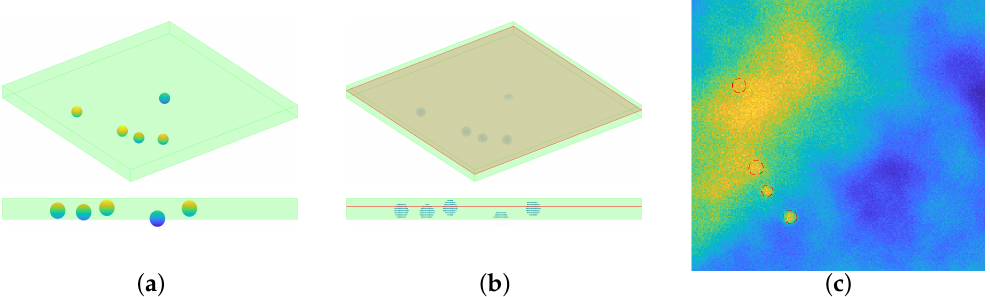
Figure 6. Visual inspection for the synthetic data generation. ( a ): the particles’ position is randomly chosen in a continuous space, and the green shaded volume represents the volume taken into consideration. Notice that a particle may not be completely included in the volume, see the bottom part of the panel ( a ). ( b ): once the resolution is chosen, the particles volume is discretized and only the voxels inside the volume are considered. One slice of the whole volume is considered: such slice is perturbed with Perlin noise, then the action of a PSF induces a blur effect and eventually Gaussian and Poisson noise are added. ( c ): the final simulated image, displayed with values in [ 0,255 ] . The dashed red lines represent the profile of the